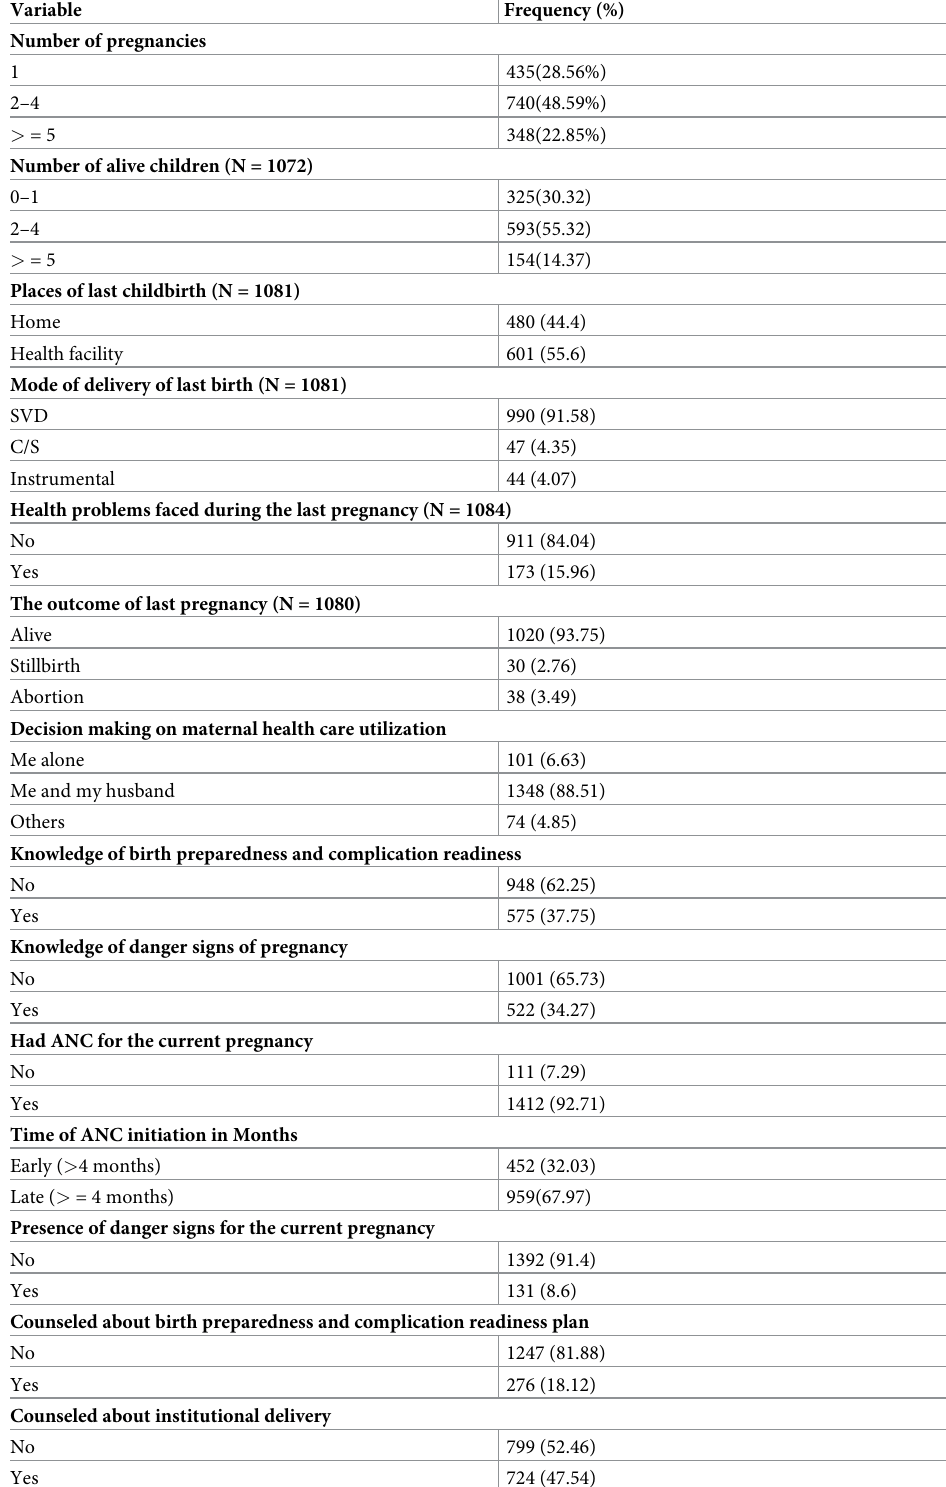
Table 2. Obstetric characteristics of study participants at North Gondar Zone, 2018 (n =